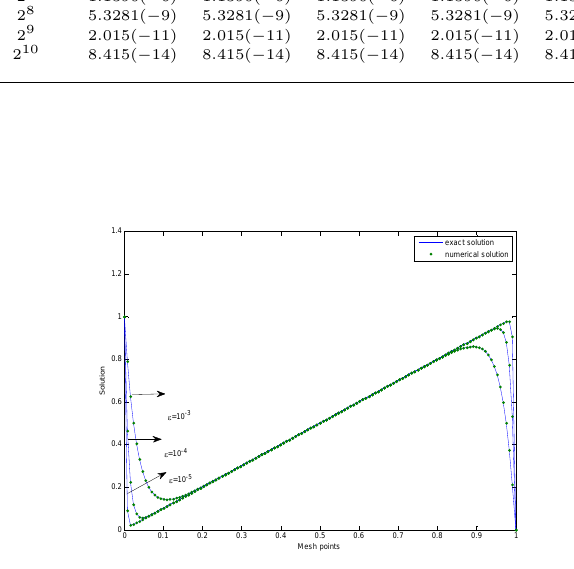
Fig 1. Graphical representation of solution in Example 1 with